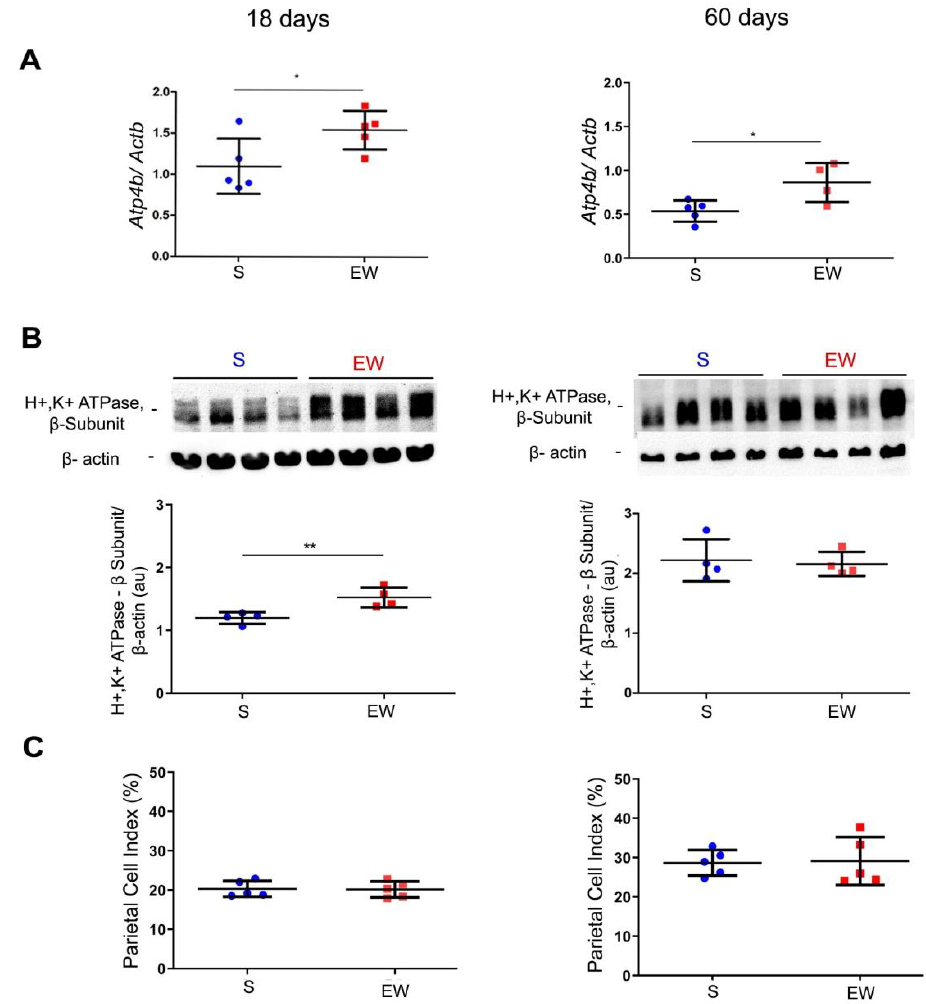
Figure 3. Early weaning effects on markers of parietal cell (PC) activity and distribution. The gastric mucosa was studied in suckling (S) and early-weanling (EW) groups at 18 and 60 days. ( A ) Expression of Atp4b after RT-qPCR represented as fold induction of internal control ( Actb ). n = 3–5 per group. Technical replicates: n = 2. ( B ) Protein levels of H+/K+-ATPase proton pump (52 kDa) were determined by integrate optical densitometry (arbitrary units) in immunoblots and compared to the internal control protein ( β -actin, 42 kDa). n = 4 per group. Technical replicates: n = 2. ( C ) The PC index (%) was obtained by counting the number of parietal cells among 1000 epithelial cells under light microscopy in HE stained sections. n = 5 per group. Individual results for S (blue) and EW (red) rats are represented and means ± SD is indicated in each group and age. After unpaired Student t test between groups in each age: * p < 0.05 and ** p < 0.01.